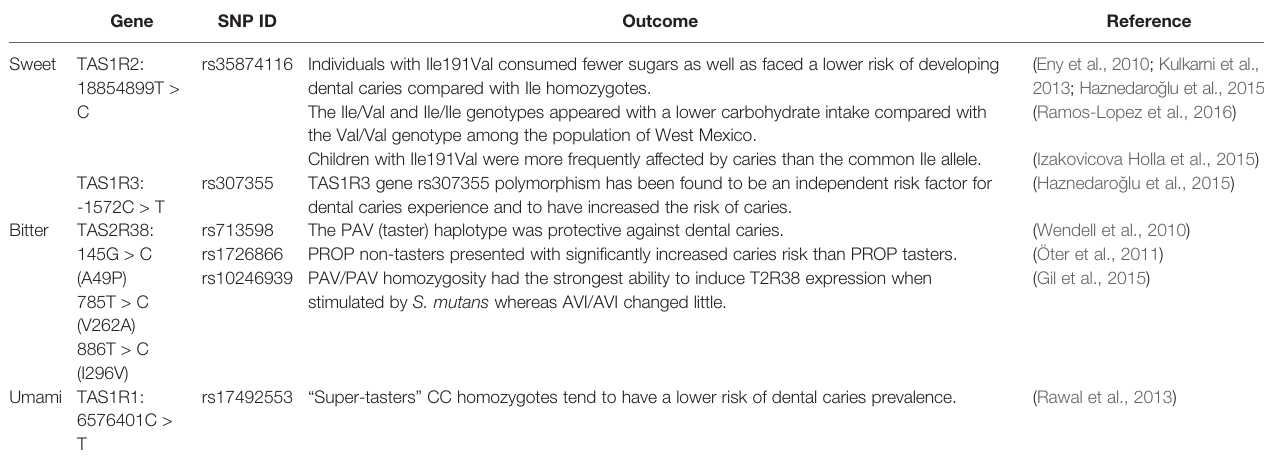
TABLE 1 | SNPs of taste receptors correlated with oral